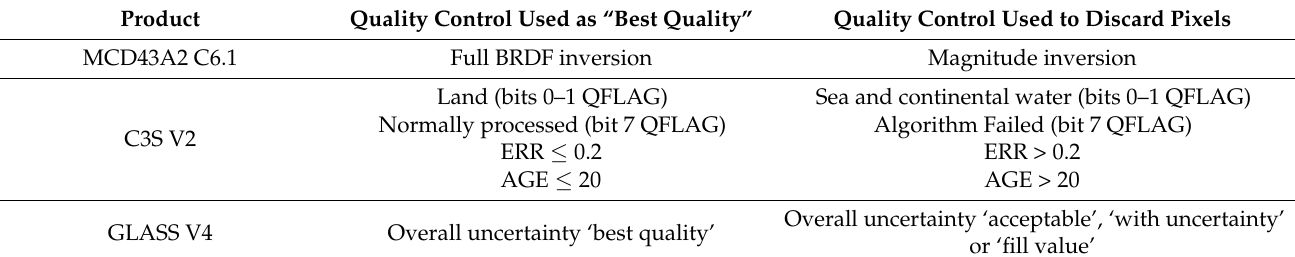
Table 5. Quality flag information used to filter pixels flagged as “low